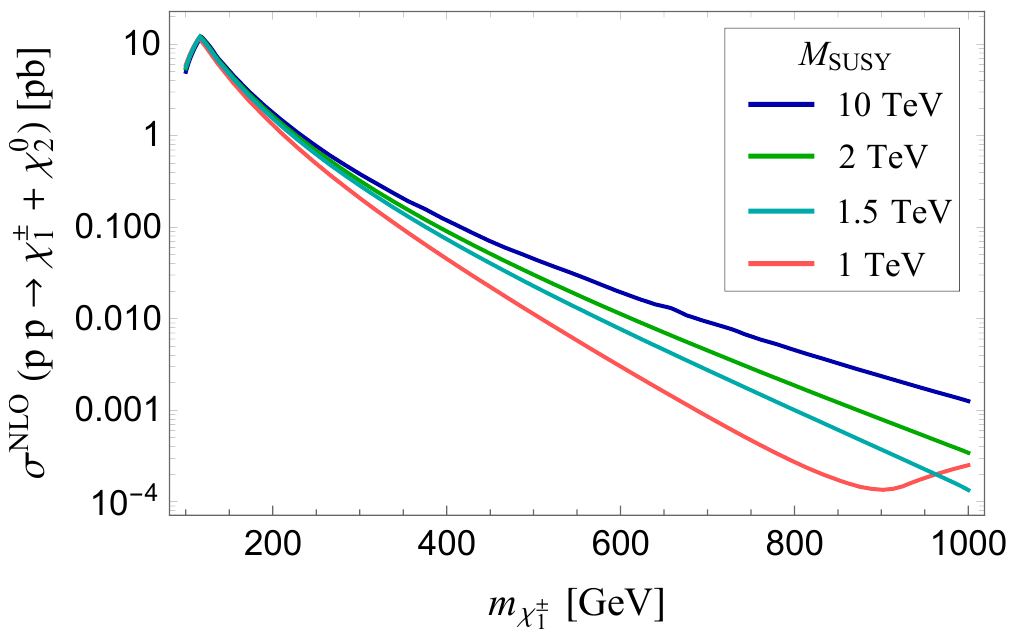
Figure 2 . Variation of the Wino-like production cross section for the 13 TeV LHC at NLO when M SUSY is varied between 1 and 10 TeV. M 1 = 100 GeV and tan β = 5 are fixed and | µ | = M SUSY